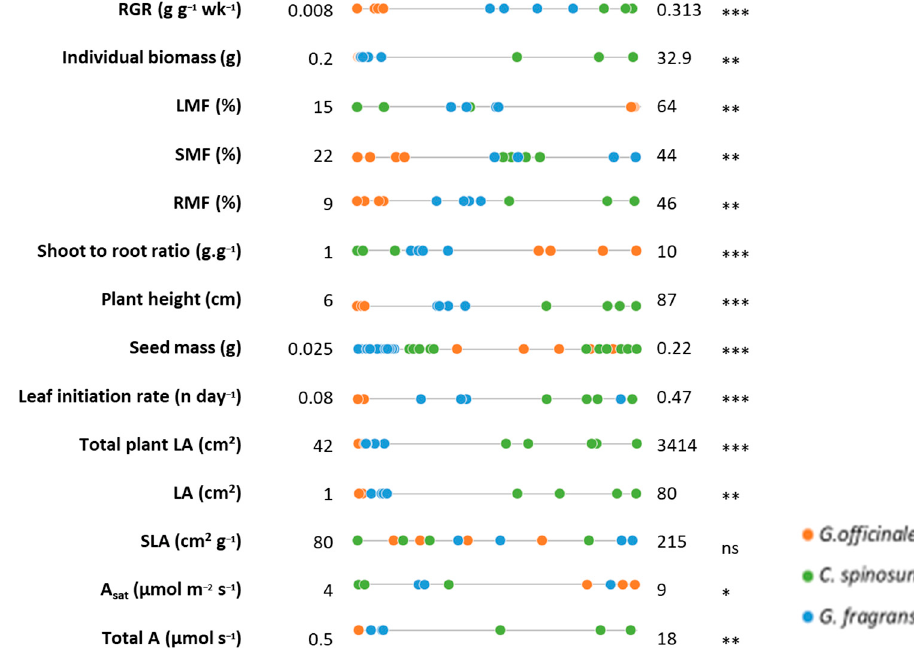
Figure 3. Growth, carbon allocation and traits of carbon acquisition in seedlings of C. spinosum , G. officinale and G. fragrans . For each trait, significant differences between species are indicated (* p < 0.05, ** p < 0.01, *** p < 0.001, ns: non significant). See Table 1 for acronyms.